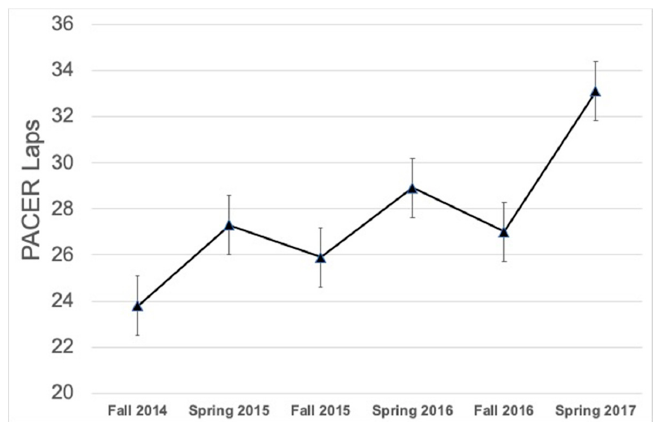
Figure 2. Mean PACER laps across time points for the total sample (means and standard errors; n = 404). Note: PACER stands for Progressive Aerobic Cardiovascular Endurance Run.